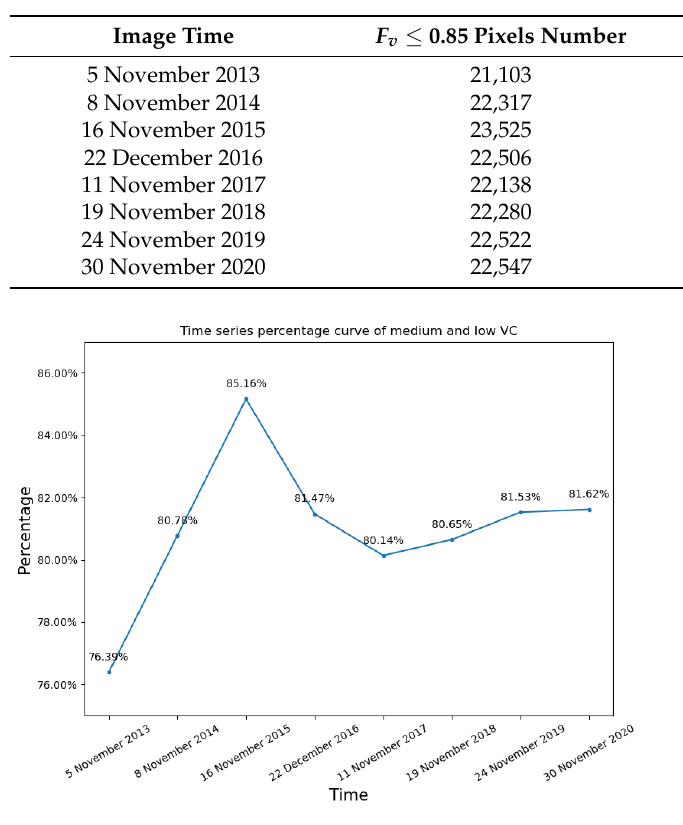
Table 4. Number and percentage of pixels with low and medium VC.